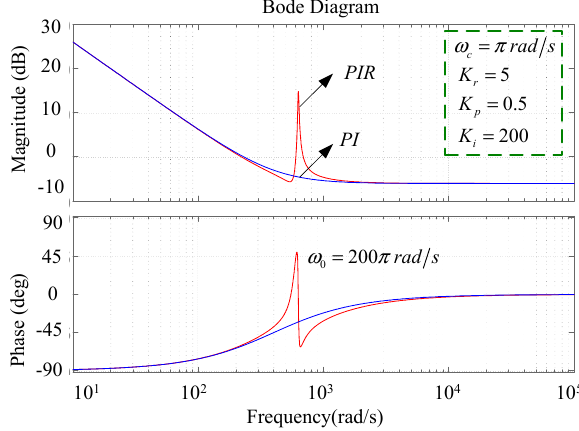
Figure 8. Block diagram of the proportional-integrational-resonant (PIR) controller.